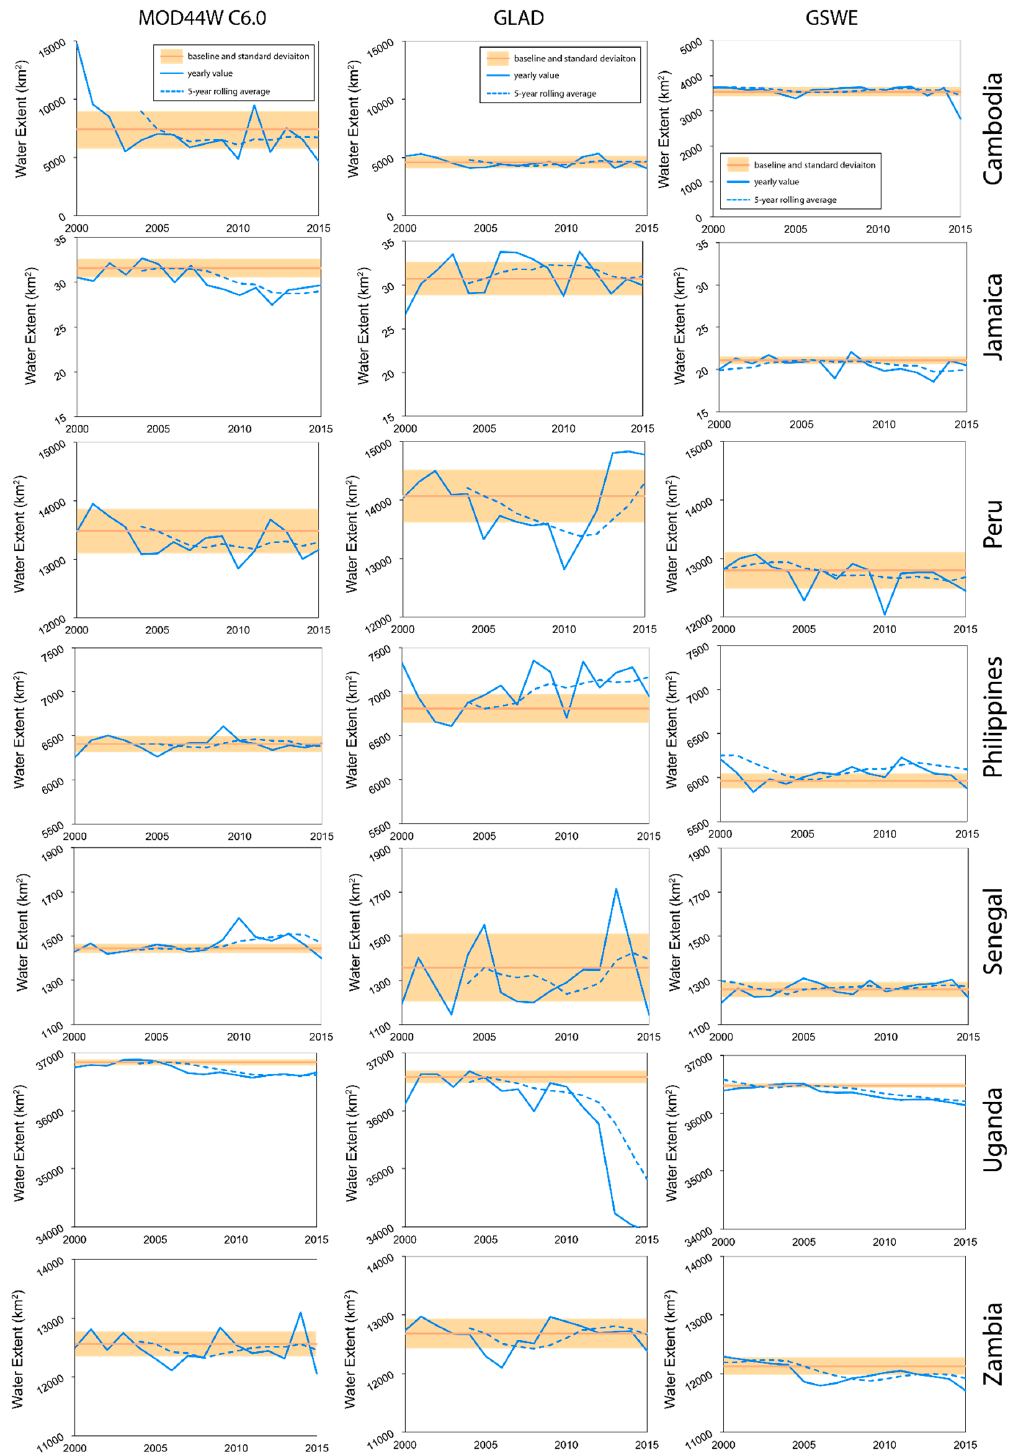
Figure 4. Spatial extent of surface water in the seven countries calculated using MOD44W C6.0 persistent water, GLAD surface water using a 75% threshold for persistent water, and GSWE permanent water for 2000 to 2015. The baseline period average and standard deviation from the baseline period average from 2001 to 2005 are shown in an orange line and light orange shaded area, respectively. Yearly aggregate of surface water extent (solid blue line) and the five-year running average (dashed blue line) are overlain.